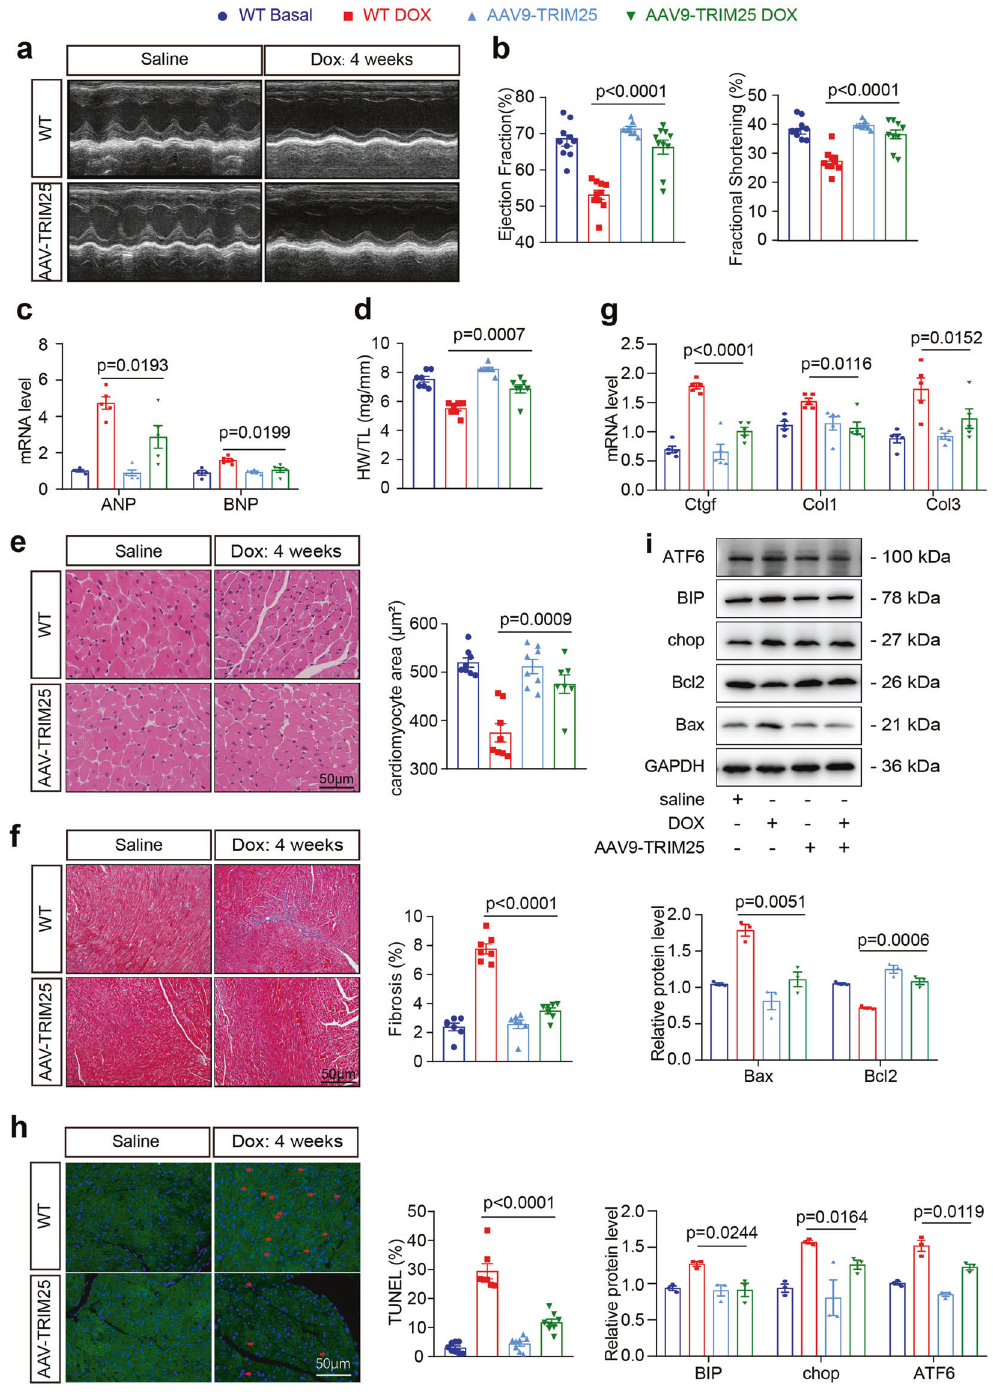
Fig. 4 TRIM25 overpression by adeno-associated virus alleviates DOX-induced cardiotoxicity in mice. WT and TRIM25 overpression (OE) mice were injected by adeno-associated virus 9 via the tail vein, and after 4 weeks, they were treated with a cumulative dose of 20 mg/kg DOX or saline by 4 weekly injections (5 mg/kg on days 0, 7, 14 and 21). a Representative M-mode echocardiographic images of WT and AAV-TRIM25 hearts 8 weeks after the fi rst DOX injection. b M-mode images from three consecutive cardiac cycles for each animal were used to calculate ventricular measurements: ejection fraction, fractional shortening. c Relative quanti fi cation of cardiac Anp (atrial natriuretic peptide) and Bnp (brain natriuretic peptide) mRNA expression levels. d The HW/TL (heart weight/tibia length) ratio as a cardiac atrophy index of DOX-treated WT and AAV-TRIM25 mice. e Representative images of H&E staining and relative quanti fi cation of cardiomyocyte area in heart sections from mice treated as in ( a ). f, g Representative images of Masson staining and relative quanti fi cation of collagen deposition in heart sections from mice. h Representative images of TUNEL staining (left) and quanti fi cation of TUNEL-positive nuclei per fi eld (right) in heart sections from WT and AAV-TRIM25 mice treated with DOX or saline. i Immunoblot (upper) and relative quanti fi cation (lower) of indicated targets in whole hearts from WT and AAV-TRIM25 mice treated as in ( a ) ( n = 3). N = 7 – 10 animals/group; Values represent mean ± SEM. P values were analyzed by one- way ANOVA test with Bonferroni post hoc test ( b – i ). Scale bar, 50 μ m in e , f and h .